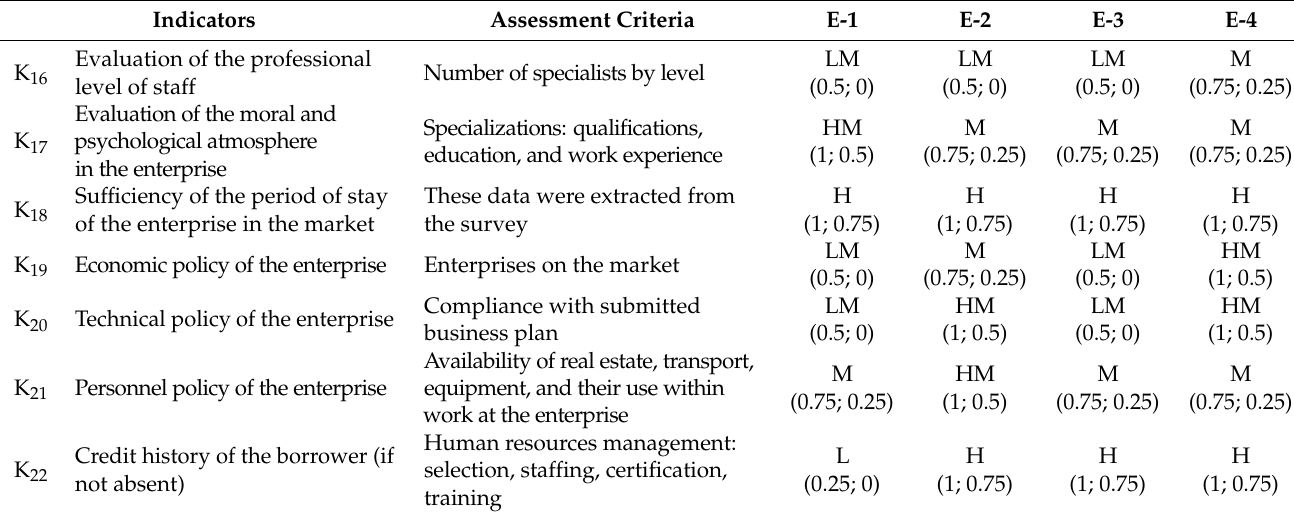
Table 5. Input variables—indicators of activity of small